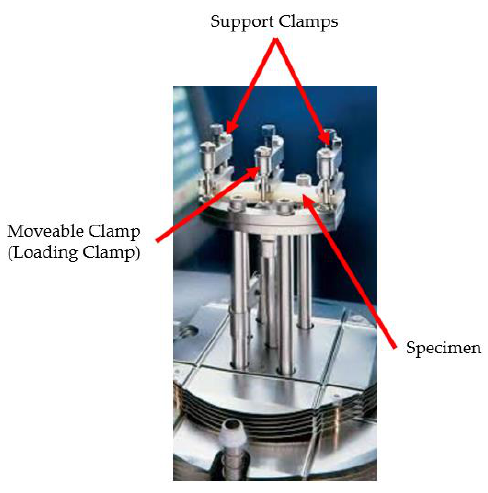
Figure 2. Clamped specimen under dual-cantilever configuration.